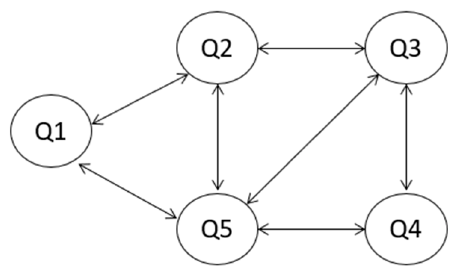
Figure 14. Significant differences between problems.